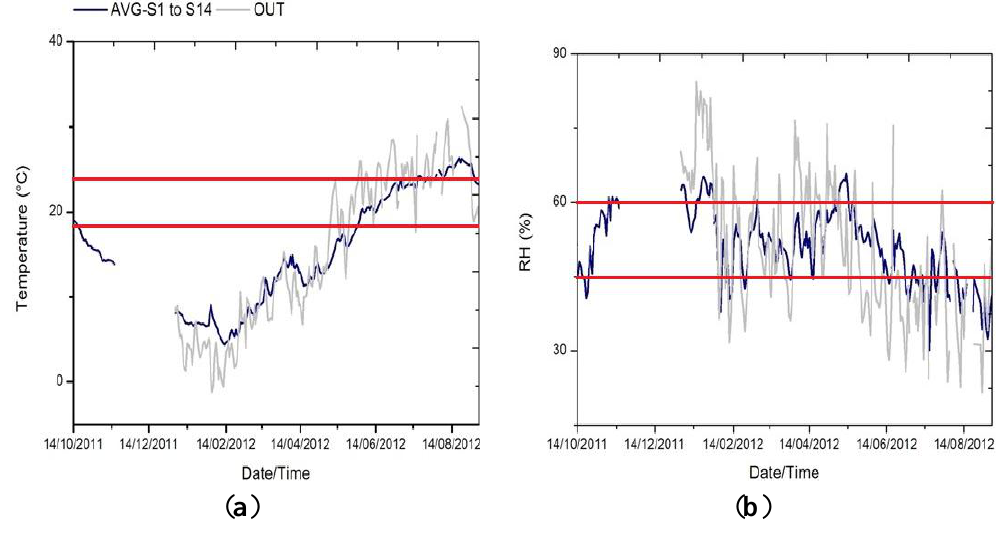
Figure 2. Time series of the average of inner sensors (from #1 to #14) (blue) and the outdoors (whose data begin on 01/04/2012, gray), ( a ) temperature, ( b ) RH.